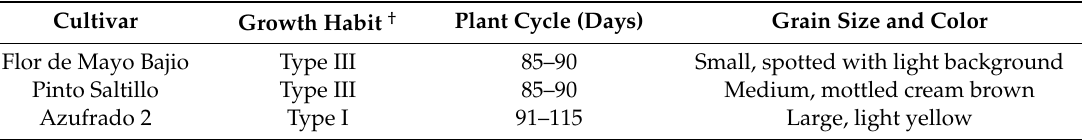
Table 1. Morphological characteristics of common bean cultivars Flor de Mayo Bajio, Pinto Saltillo, and Azufrado 2.